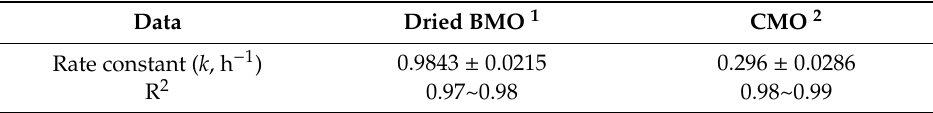
Table 1. Kinetic parameters of manganese oxides.